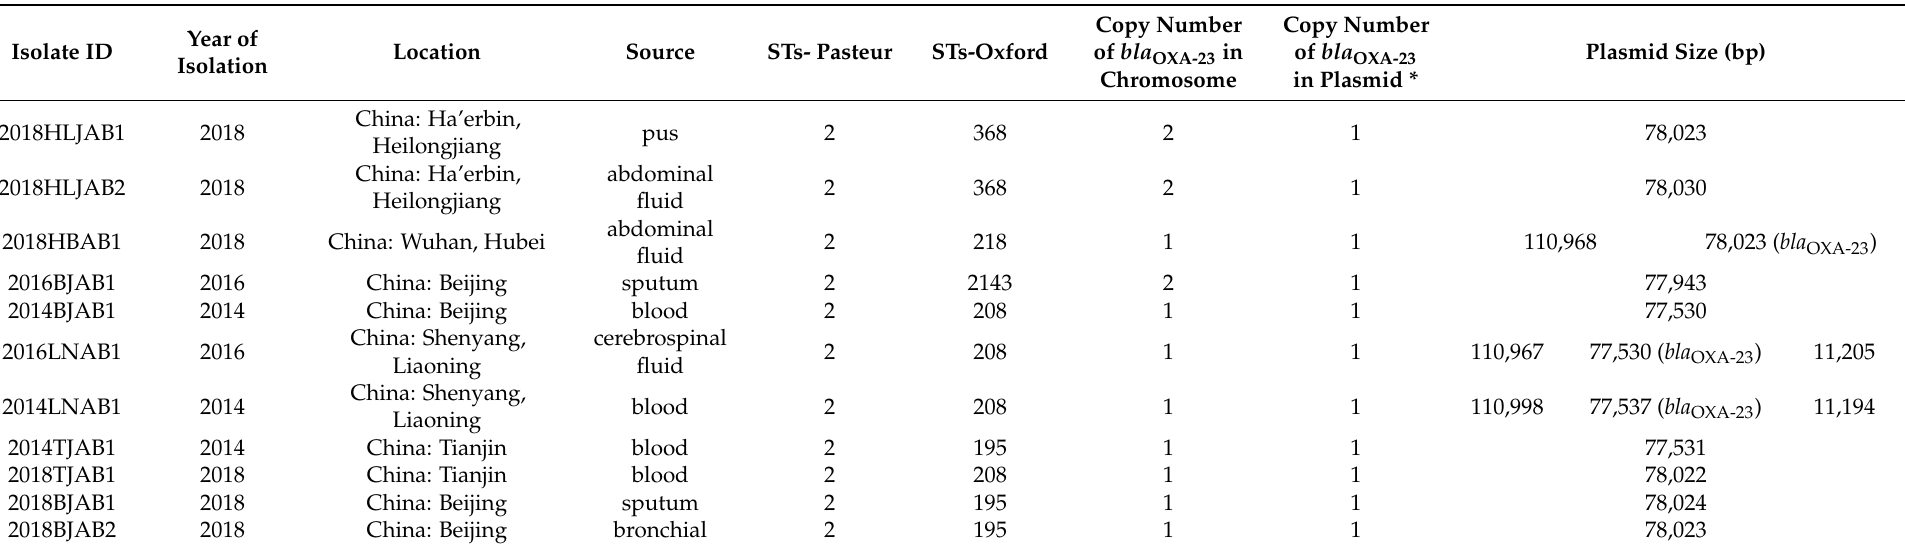
Table 1. Characteristics of A. baumanii that co-existed bla OXA-23 in chromosome and plasmid in our